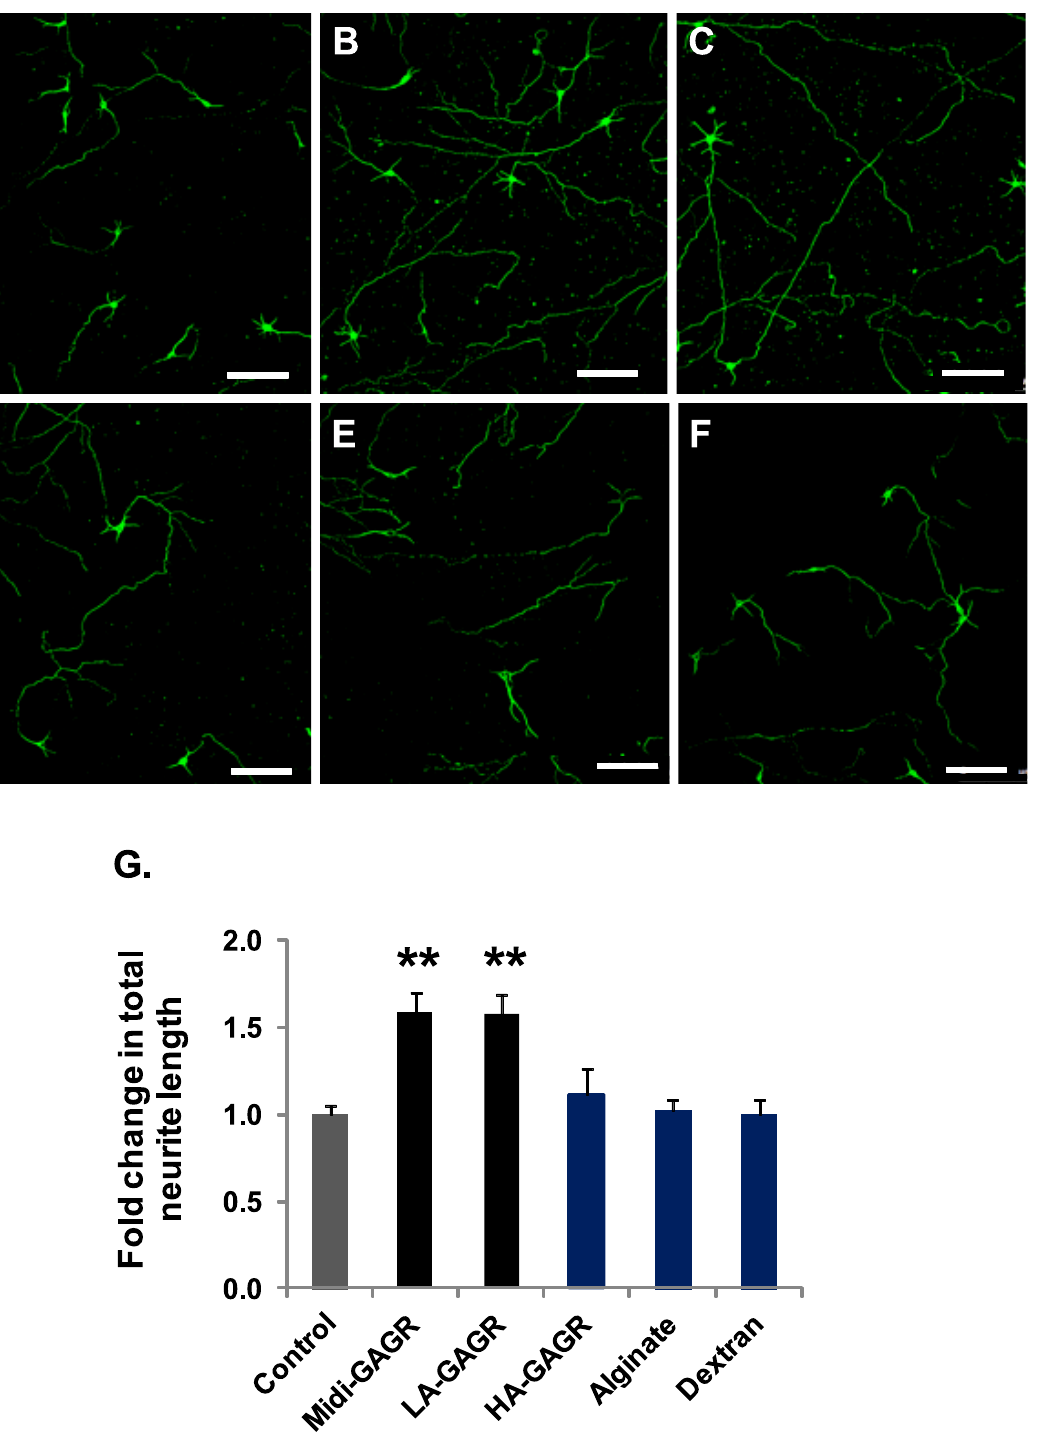
Fig 7. Midi-GAGR enhances neuritogenesis in mouse cortical neurons. (A-F) Mouse cortical neurons (E17, DIV4) were treated with H 2 O (vehicle) (A), 1 μ M midi-GAGR (B), 0.1 μ M LA-GAGR (C), 0.01 μ M HA-GAGR (D), 1 μ M alginate (C), or 1 μ M dextran (F) for 48 h and immunostained with anti- α -tubulin antibody. Scale bar = 100 μ m. (G) Bar graphs show average fold changes in the total neurite length of mouse cortical neurons in response to different polysaccharides (mean ± SEM of, at least, three independent experiments). ** , p < 0.01 compared to control.